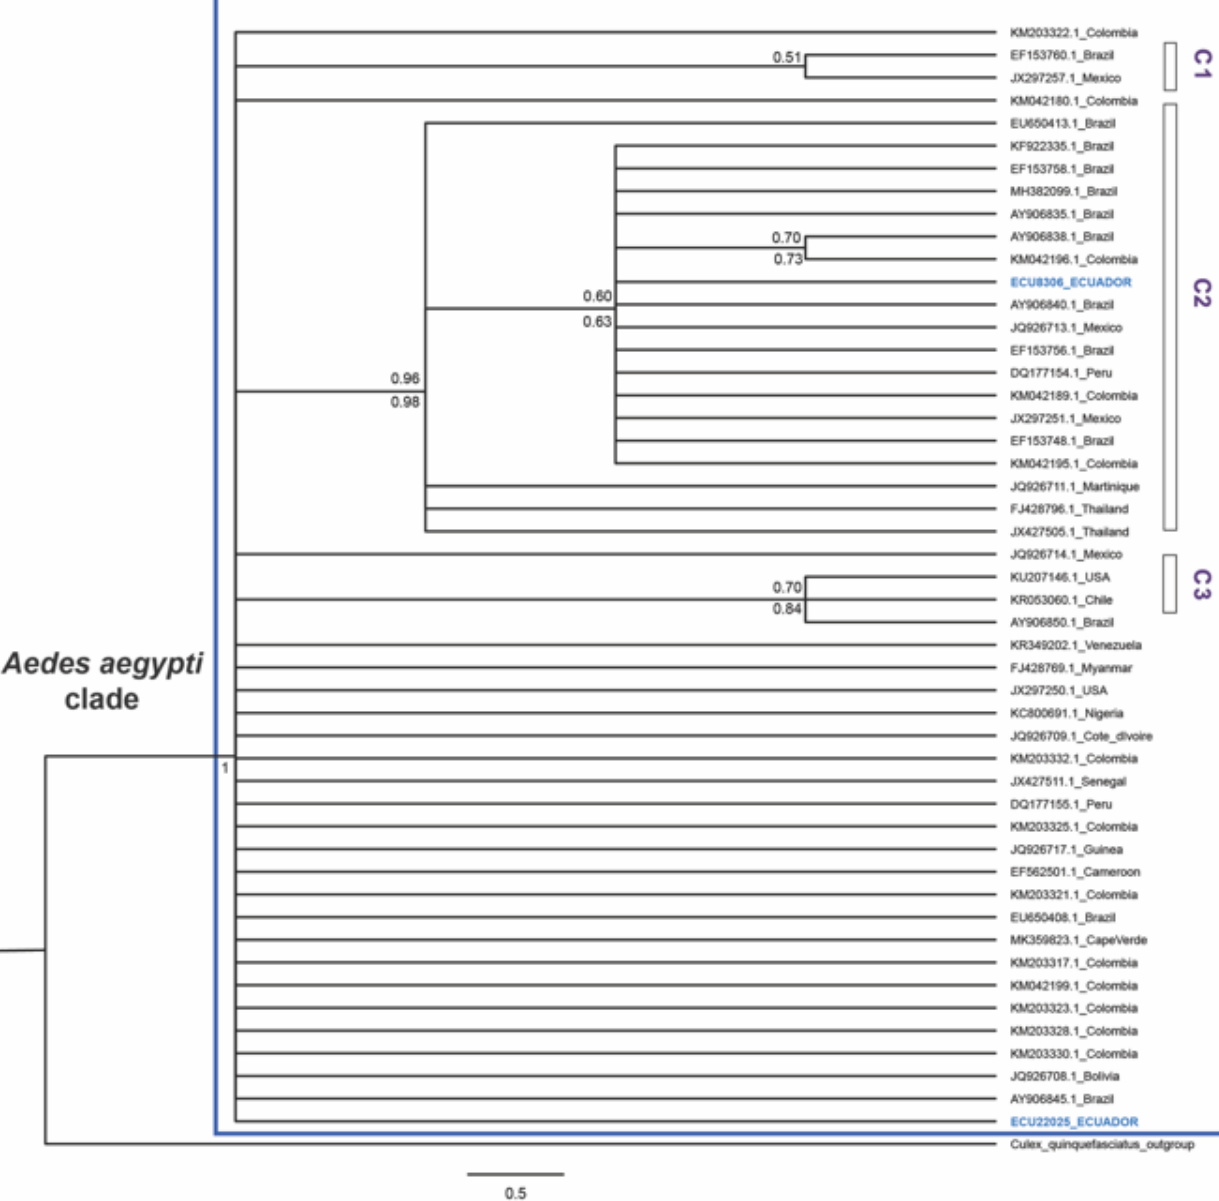
Figure 3. Maximum likelihood tree for ND4 mitochondrial marker of Aedes aegypti with haplotypes from around the world, including the two Ecuadorian haplotypes. Bootstrap support values for the ML tree are presented below branches and posterior probabilities are presented above the branches. Ecuadorian haplotypes are highlighted in blue. C1 refers to genetic cluster 1; C2 genetic cluster 2 and C3 genetic cluster 3. Table 2. Ecuadorian haplotypes of the ND4 mitochondrial marker were identified in Aedes aegypti and compared to haplotypes found in the published literature. X refers to the absence of the haplotype.